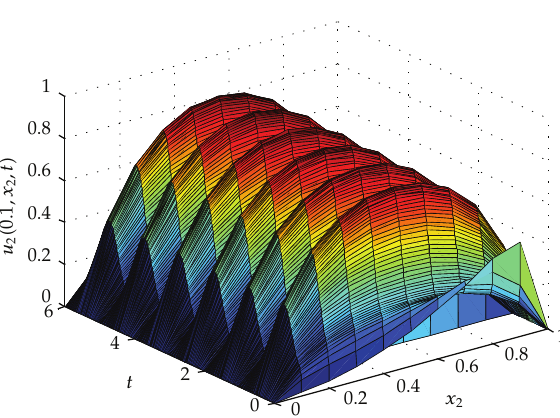
Figure 4: The surface of u 2 (cid:3) t, 0 . 1 ,x 2 (cid:4) when x 1 (cid:8) 0 . 1.